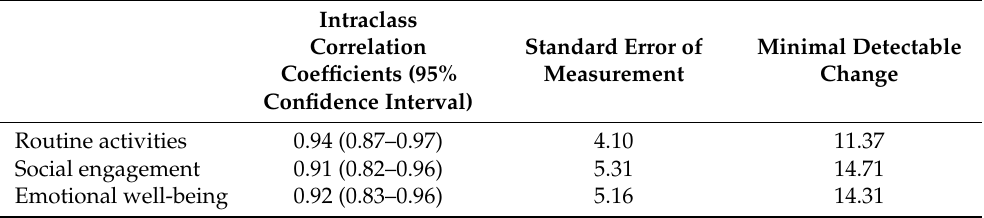
Table 3. Test–retest reliability, standard error of measurement, and minimal detectable change of the Chinese version of the Oxford Participation and Activities